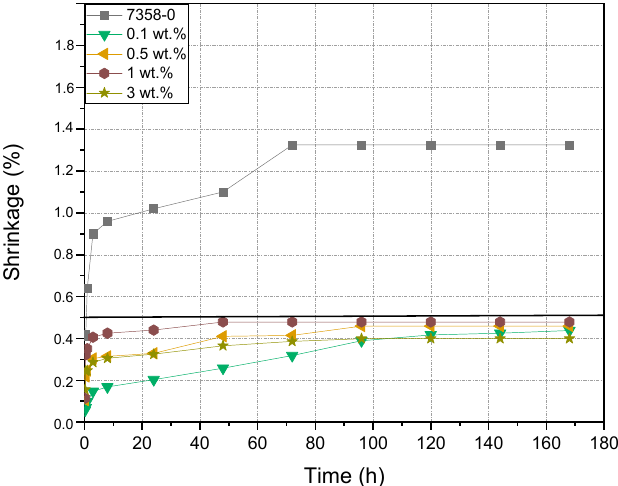
Figure 14. Influence of palygorskite-0.5MPTMS addition on shrinkage Si-PSA.